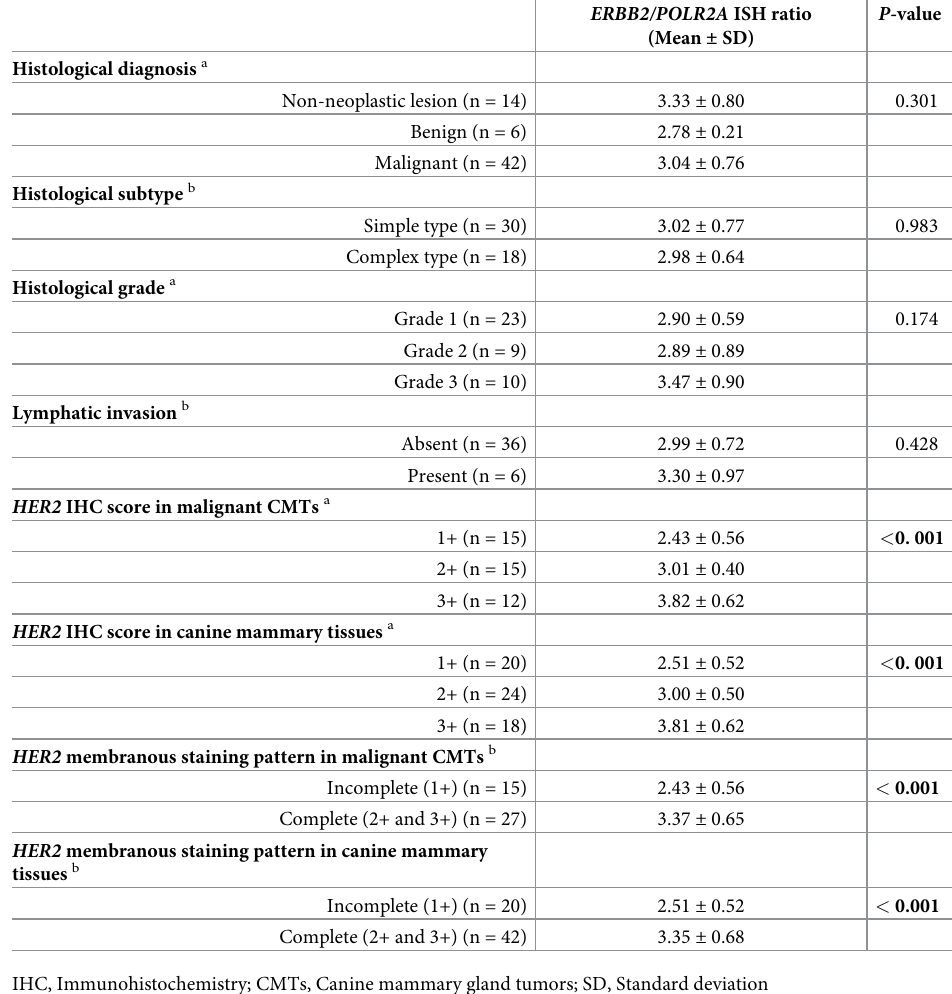
Table 2. Association between the ERBB2/POLR2A ISH ratio and parameter including malignancy, histological subtype, histological grade, presence of lymphatic invasion, and HER2 IHC